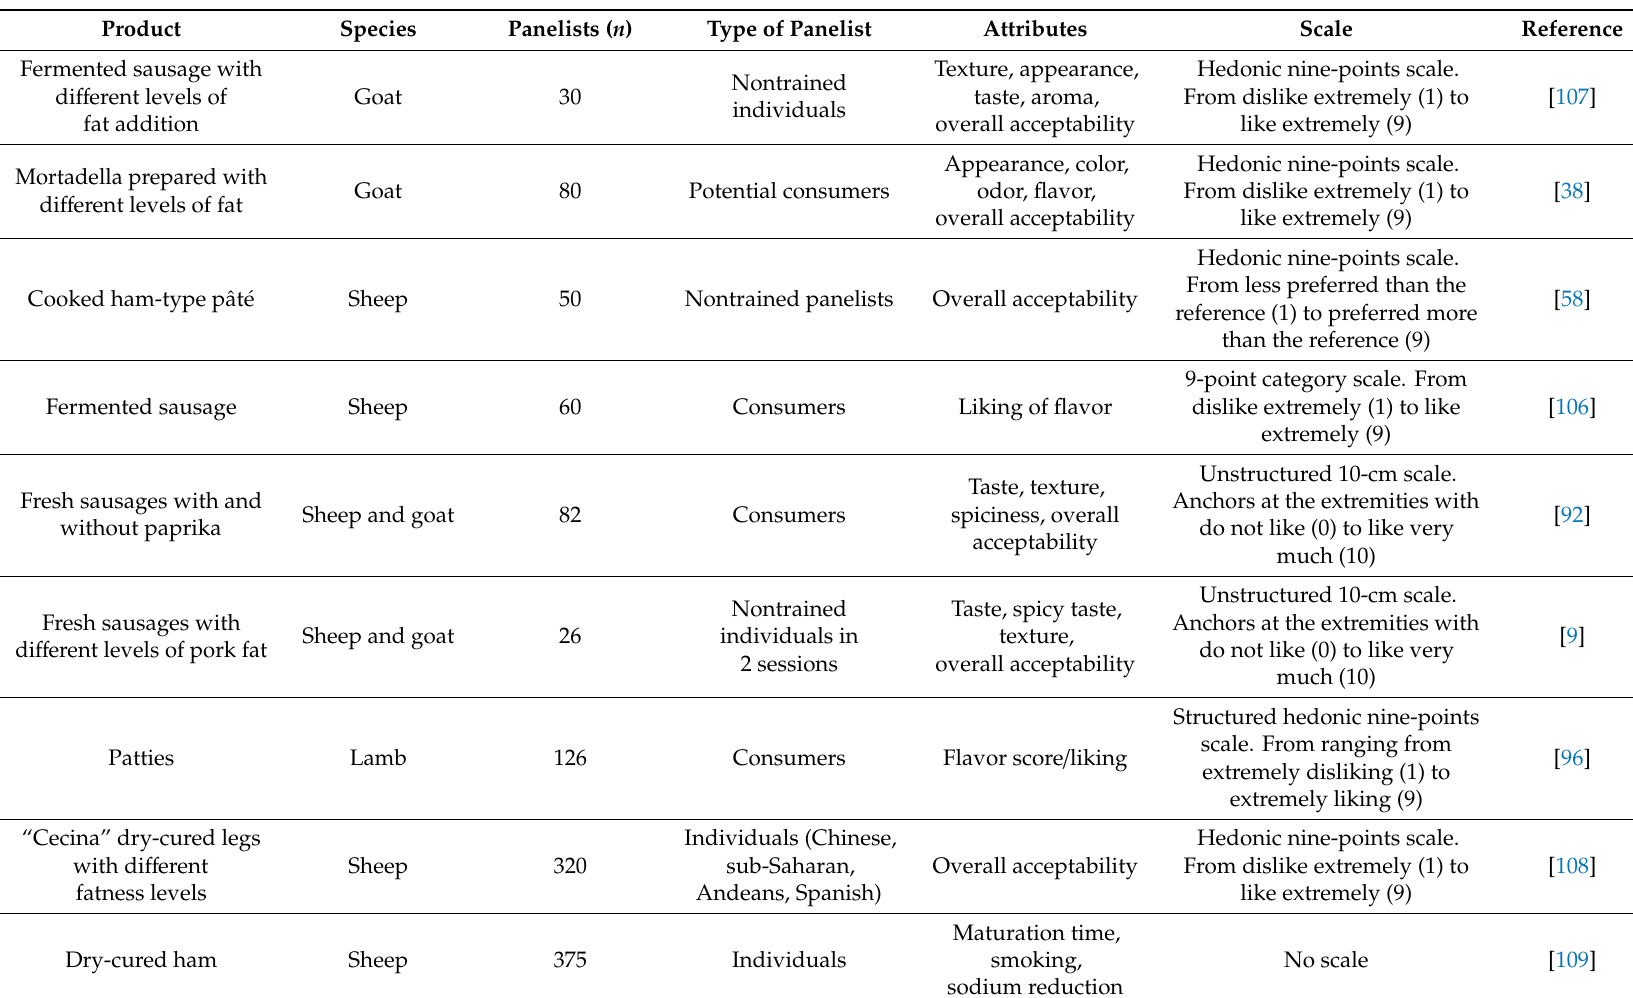
Table 3. Studies on the sensory evaluations of new products from sheep and goat meats using hedonic evaluations with di ff erent type of